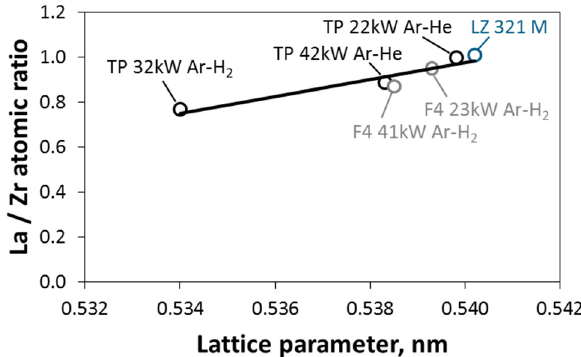
Figure 1. Correlation of La depletion and LZ Fluorite lattice parameter for different torch types (TP: TriplexPro™-210, F4 gun), input power levels, and plasma gas compositions; the data of powder feedstock 321 M is given as a reference.